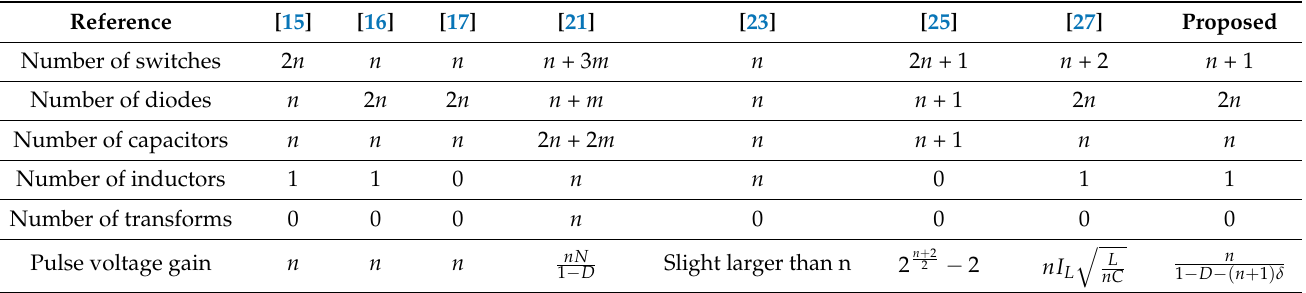
Table 1. Comparison between the proposed structure and 6 other